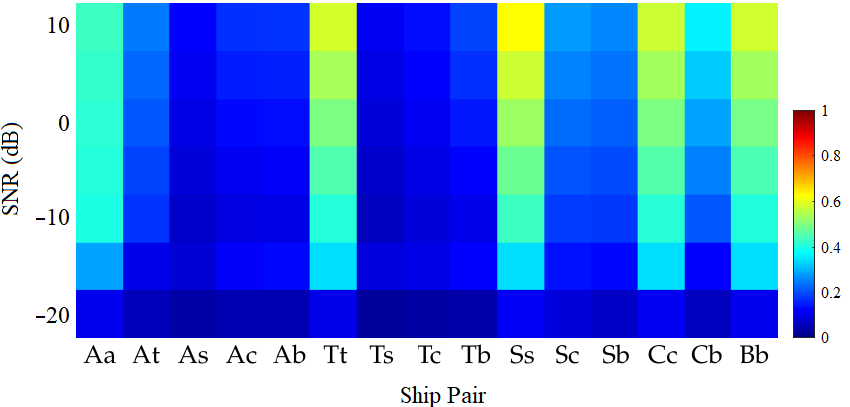
Figure 21. SSIM indices of ship pairs under different levels of